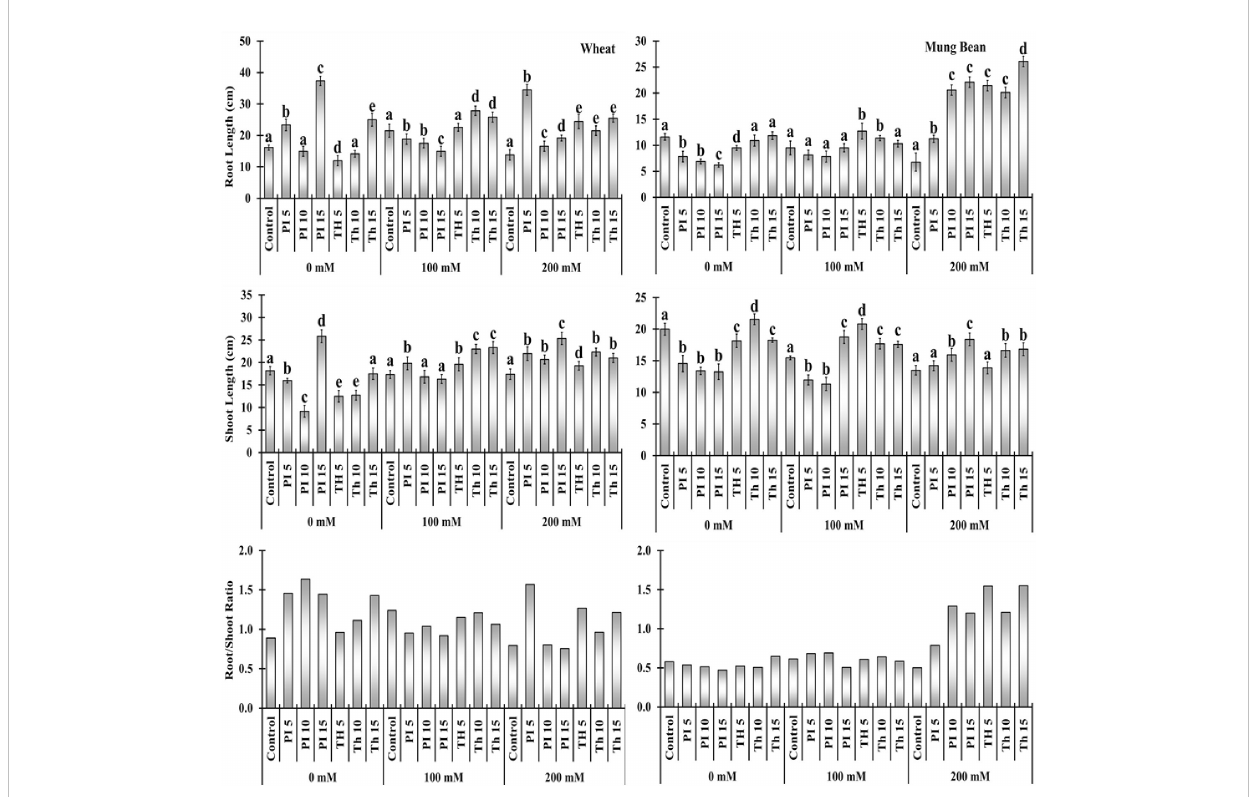
FIGURE 2 Effects of bio- priming with fungal endophytes on Root Length (RL), Shoot Length (SL) and Root/Shoot ratio of wheat and mung bean grown under saline environment Note : The symbols on the horizontal axis represents: Control: Seeds without priming, Pl = Seed priming with Paecilomyces Trichoderma hamatum 5, 10, 15 = duration of bio-priming in minute, 0, 100 & 200 mM NaCl concentration. On lilacinus , Th = Seed priming with bars, vertical lines represent ± Mean Standard Error (S.E) and similar alphabets represents non-signi fi cant difference between the the means of treatment at p<0.05